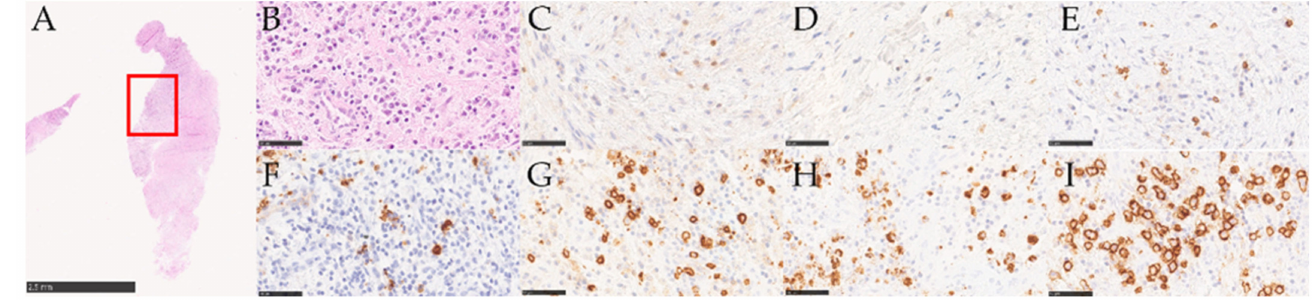
Figure 5. Stained samples of a PD lesion: ( A ) overview of a section stained with HE; ( B ) detailed view of ( A ); ( C ) CD3+; ( D ) CD4+; ( E ) I CD8+; ( F ) CD15+; ( G ) CD20+; ( H ) CD68+; ( I )